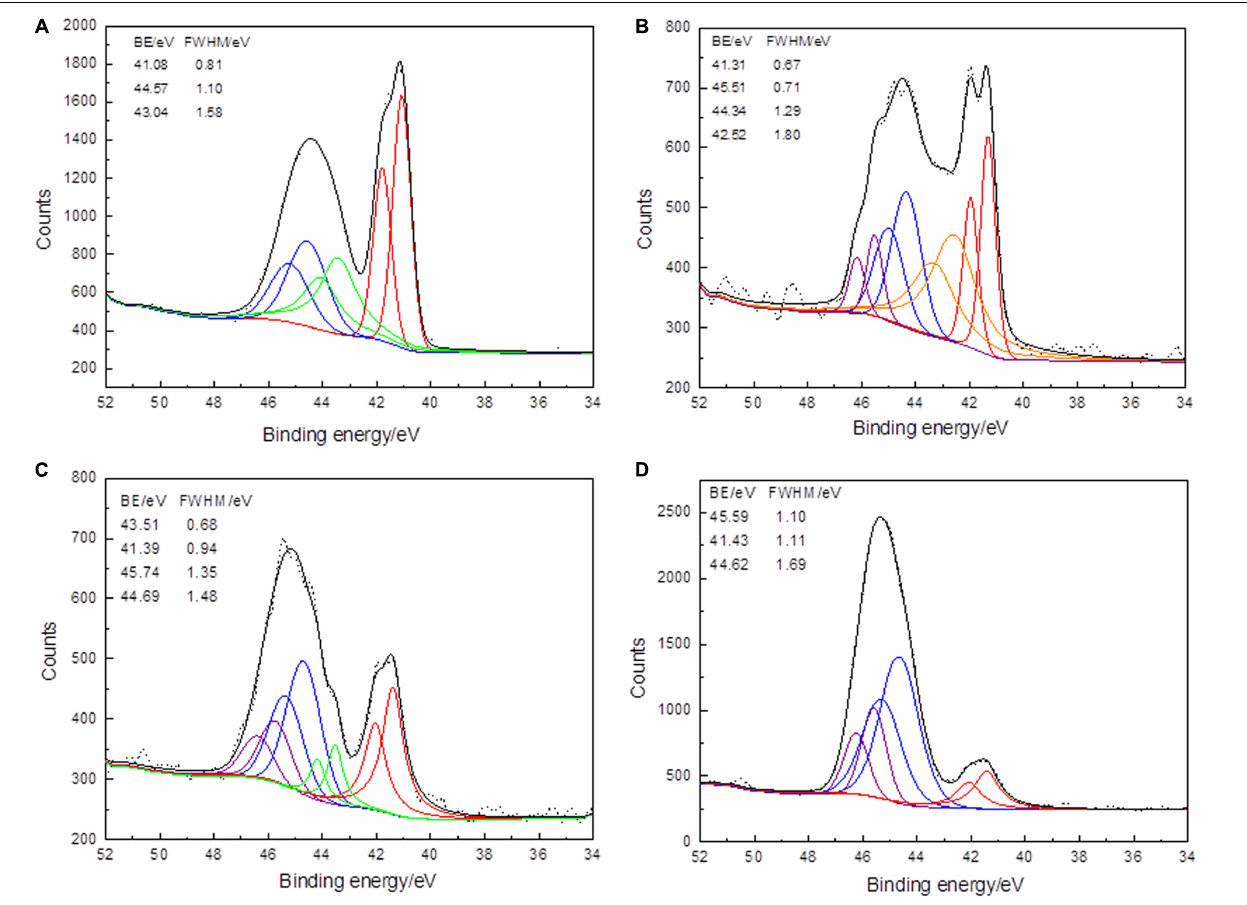
FIGURE 5 | XPS As 3d spectra of arsenopyrite before (A) and after bioleaching for 2 days (B) , 6 days (C) , and 10 days (D) at 45 ◦ C with initial pH 1.5. Short dots present the experiment data. Fits to data and the background are in black and dark yellow curves. The curves in red, blue, green, olive, and purple present the spin-orbit split peaks of As–S, As(III)–S, and As(V)–O.